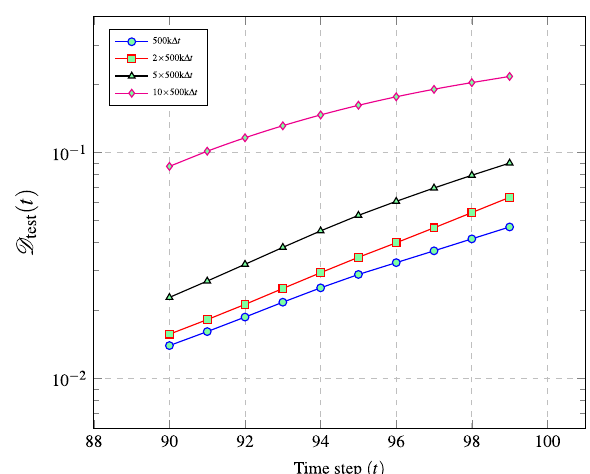
Fig. 4 Variation of forecasting error on test data for models trained on data with different spacing in time. Spacing in time tested are: 500k Δ t , 2 × 500k Δ t , 5 × 500k Δ t , 10 × 500k Δ t . D test ð t Þ represents the relative L 2 error computed across the samples in test dataset at different time